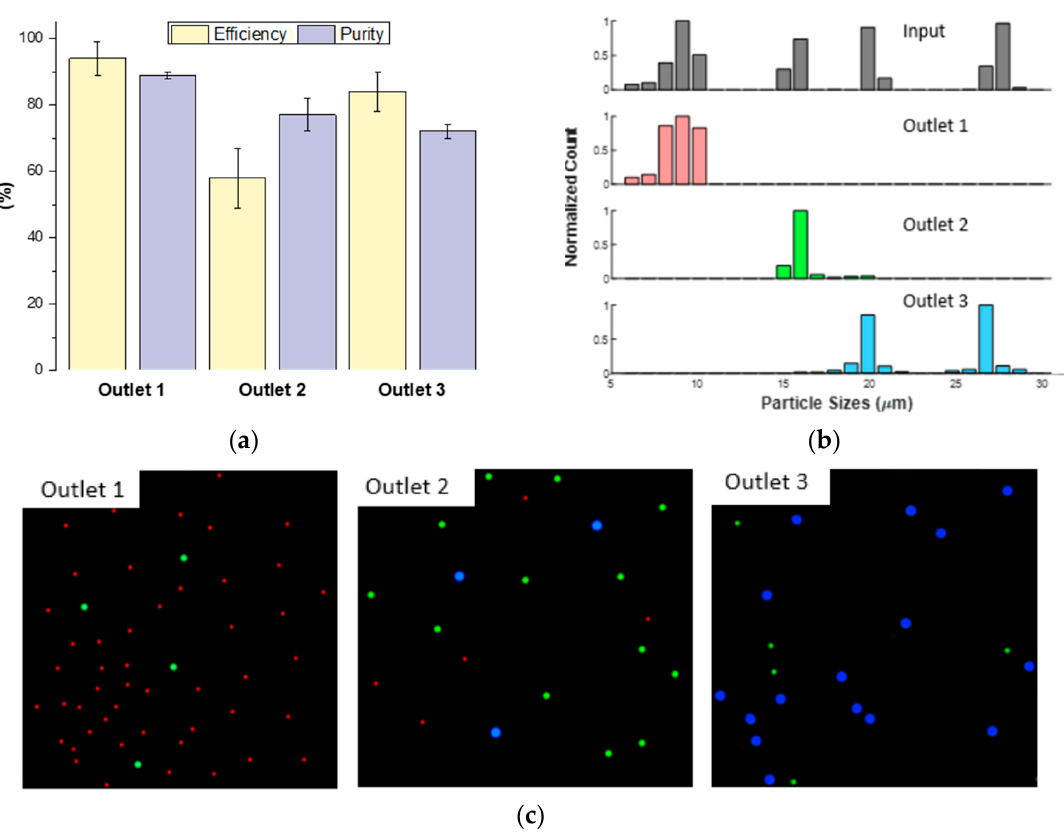
Figure 7. Mixed particle experiment of 7 μ m (red), 15 μ m (green) and 26 μ m (blue) at 300 µL min − 1 , 1:4 ratio, 0.59 resistance ratio to show device optimization. ( a ) Purity and efficiency of outlets. ( b ) Initial particle sizes and particle sizes in outlets after experiments. ( c ) 10X images show the purity based on the amount of colors in each outlet.